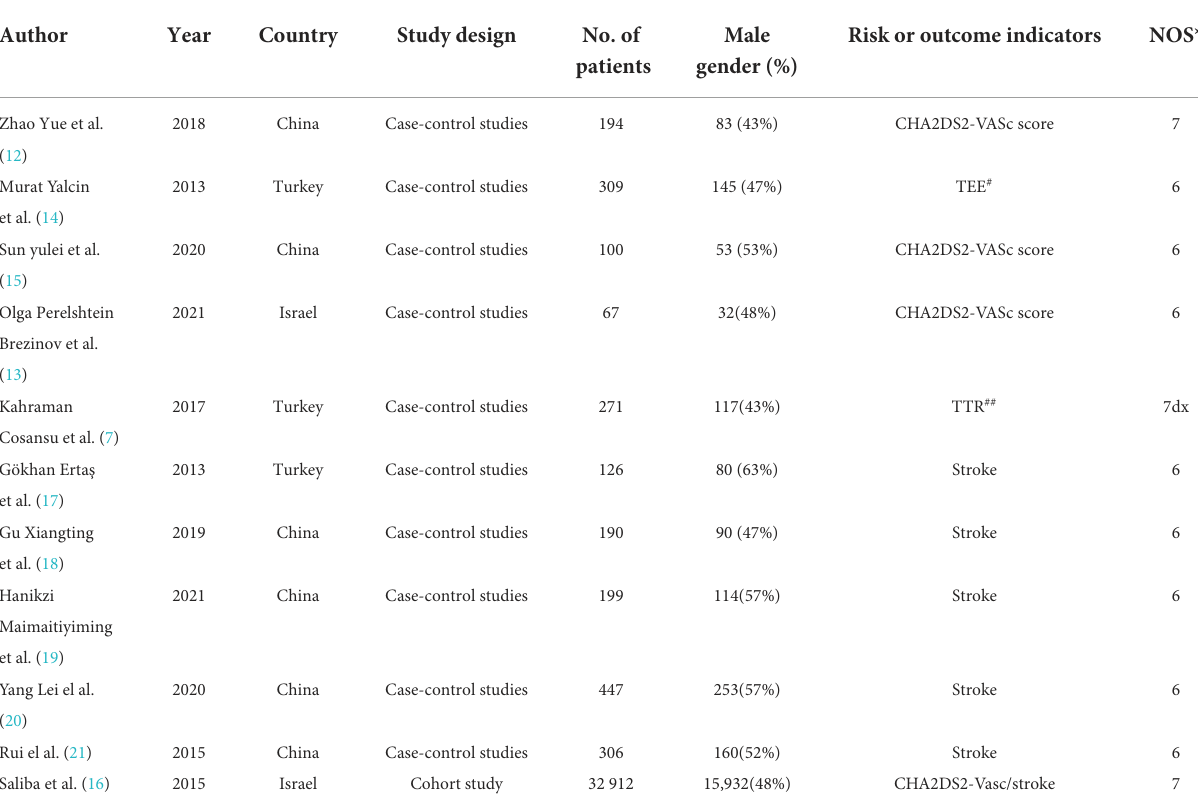
TABLE 1 Study details, baseline demographic, and clinical